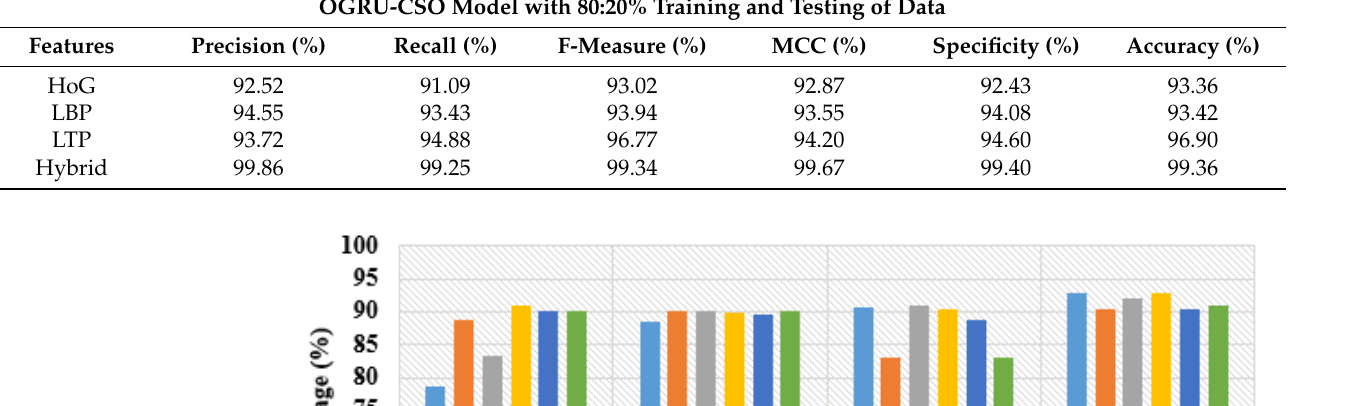
Table 6. Simulation results of the proposed model by varying the features with 80:20% training and testing of data.